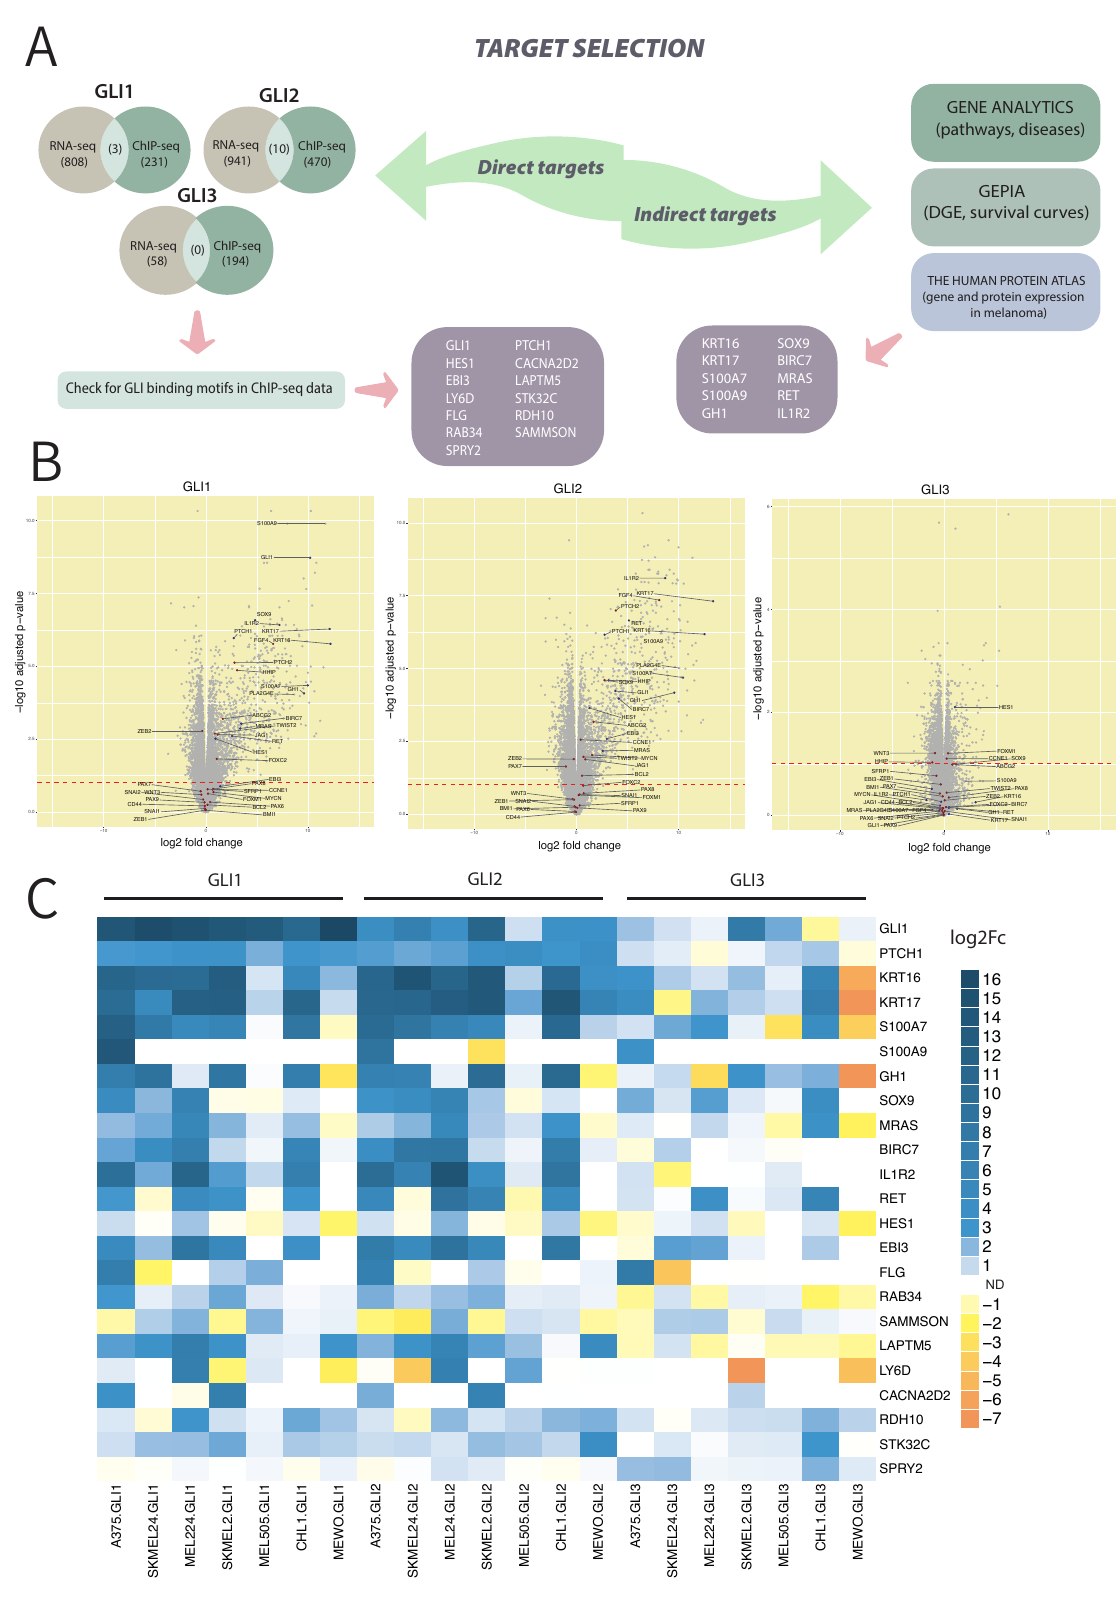
Figure 4. Validation of 21 selected DEGs. ( A ) Schematic representation of choosing DEGs for qPCR validation. ( B ) Volcano plot represents previously identified targets of HH-GLI signaling in red and targets selected for validation in this study in blue for each GLI protein. ( C ) Heatmap showing